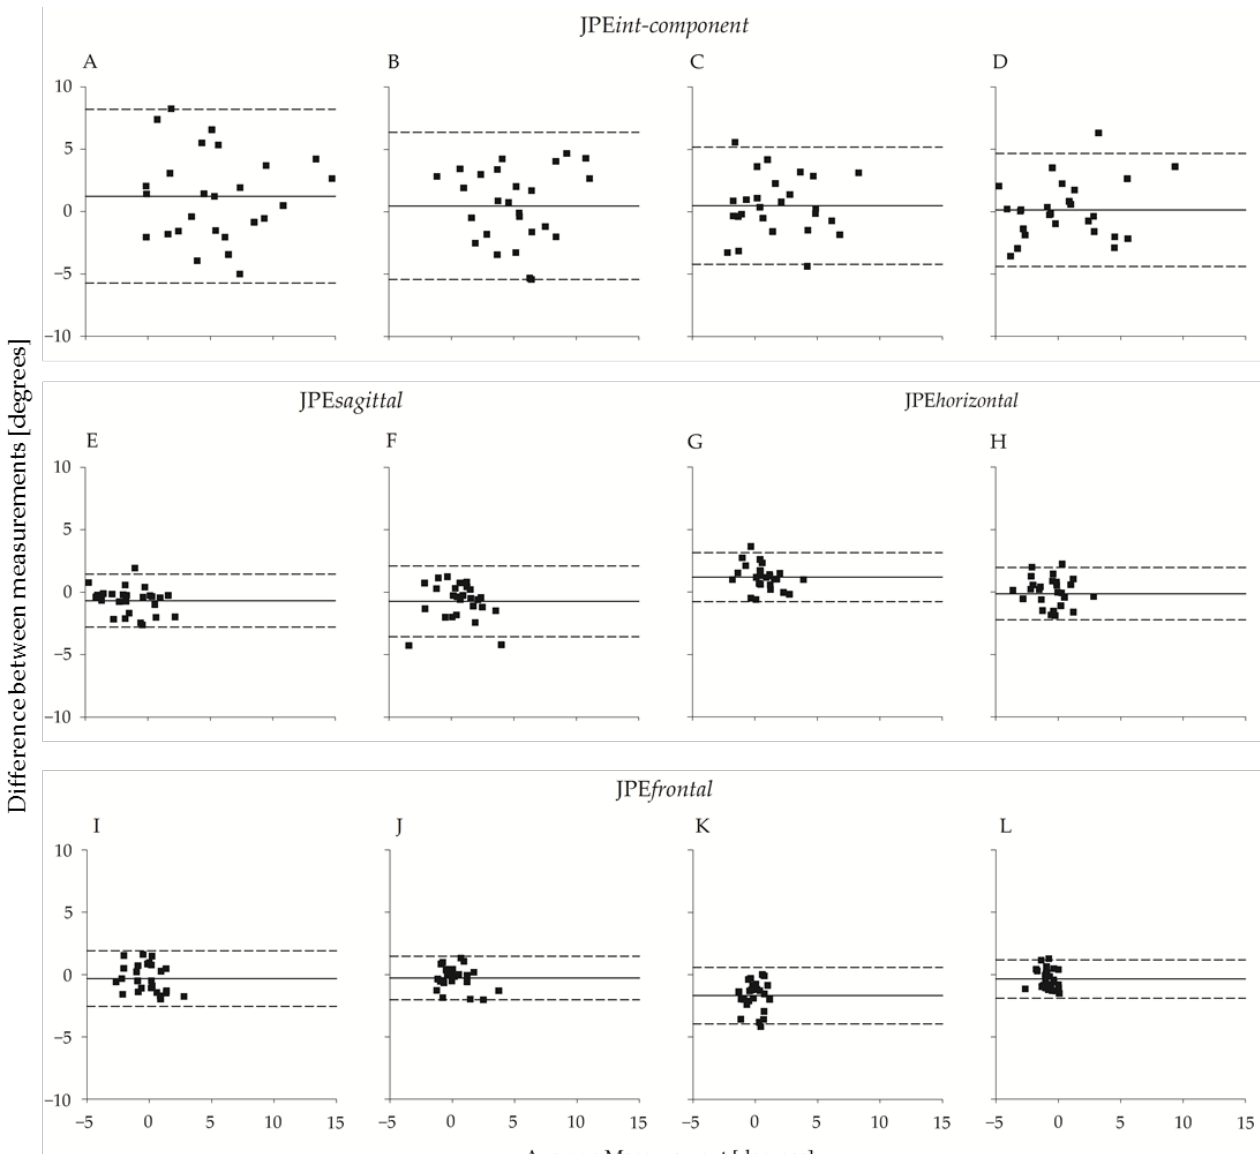
Figure 6. Bland – Altman plot (N = 26) of JPE int-component , JPE sagittal , JPE horizontal , and JPE frontal with respect to the two operators. From top to bottom, the first row refers to JPE int-component , the second row refers to JPE sagittal and JPE horizontal , and the third row refers to JPE frontal . In the uppermost row, each panel refers to one of the four directions: ( A ) right rotation; ( B ) left rotation; ( C ) extension; ( D ) flexion. Below ( A , B ), the corresponding unintended components in the sagittal and frontal planes (( E , F ); ( I , J ), respectively) are considered. Below ( C , D ), the corresponding unintended components in the horizontal and frontal planes (( G , H ); ( K , L ), respectively) are considered. Abscissa axes report between-operators average ( ◦ ), and the ordinate axes report between-operators difference ( ◦ ). The continuous line refers to the mean of the differences; the dashed lines represent 95% limits of